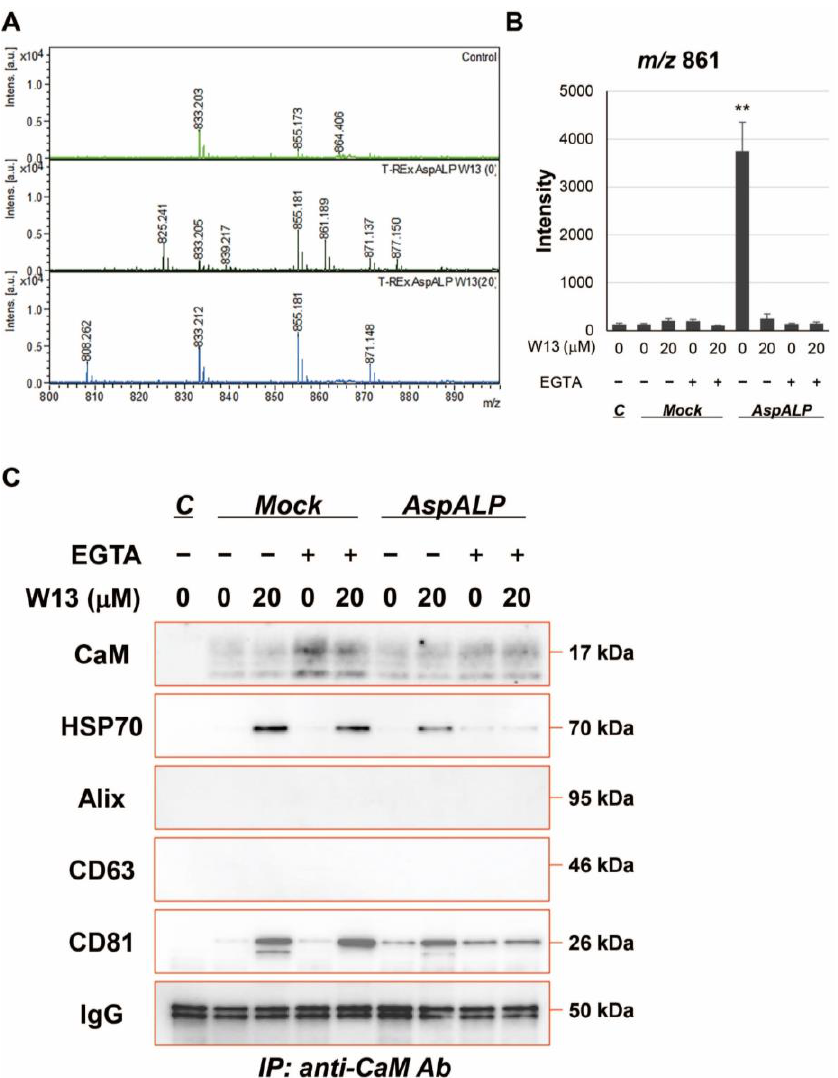
Figure 5. Interaction of CaM with HSP70 and CD81 in T-REx cells ( A ) The peptide solution extracted from immunoprecipitants with the CaM antibody from T-REx cells was analyzed by MALDI-TOF-MS. ( B ) The peak intensity at m/z 861 was measured by MALDI-TOF-MS. ** p < 0.01 vs. Mock cells in the absence of W13 and EGTA. C; control, Mock; T-REx Mock, AspALP; T-REx AspALP. ( C ) Western blot analysis of immunoprecipitants with the CaM antibody from T-REx cells. Representative images from three independent experiments.